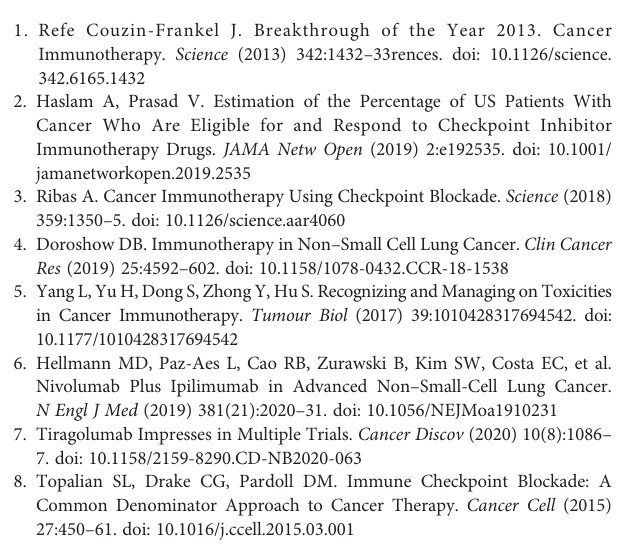
codon. The sequences of the primers used for ARMS-QPCR are indicated in bold font, and the sequence of the probe is shaded. Supplementary Figure 2 | Percentage of CD137+CD4+ T cells in the blood. (A) Gated CD3+, (B) CD4+, and (C) CD137+CD4+ T cells. (D) The percentage of CD137+CD4+ T cells in healthy controls and lung cancer patients. The error bars represent the SEMs. Supplementary Figure 3 | Correlation of Treg+ cell density in the tumor microenvironment with OS. Foxp3+ cells in the tumor microenvironment in TMAs from 82 lung cancer patients were detected by multiplexed QIF. (A) , Impact of Foxp3+ cell density on patient OS. Dichotomization was based on the median: red line, patients in the low-density group; blue line, patients in the high-density group. Log-rank P values are shown for each graph. (B) , Correlation of Foxp3+ cell density with OS in patients with a high number of in fi ltrating CD137+CD8+ cells in the tumor microenvironment. CD137+CD8+ cell dichotomization was based on the median. Supplementary Figure 4 | Structure and speci fi city of the therapeutic antibodies. (A) , Structural diagram of the therapeutic antibodies used in this study. A wild-type CD137 mAb (Wt-mAb, mIgG2a) and mutant CD137 mAb (Mut-mAb, mIgG2a) with D265A, N297A, L234A, L235A and P329A mutations in Fc g R were created via gene synthesis and expressed using a eukaryotic expression system. (B) , Binding of therapeutic antibodies to mouse CD137-His. The error bars represent the SEMs. Supplementary Figure 5 | Association of mCD137 protein expression with sCD137 protein expression. (A) , mCD137 expression and sCD137 levels in cell- free culture supernatant from non-Tregs and Tregs cultured under the indicated cell culture conditions for 3 days. (B) , mCD137 expression on CD4+ T subsets grown under the indicated culture conditions and sCD137 levels in the corresponding cell-free culture supernatant. (C) , mCD137 expression on CD8+ T subsets grown under the indicated culture conditions and sCD137 levels in the corresponding cell-free culture supernatant. Unstimulated, complete medium only; IL-2, complete medium + IL-2 (100 U/ml); CD28 mAb, complete medium + anti-human CD28 mAb (1 m g/ml); CD3 mAb, complete medium + anti-human CD3 mAb (OKT3, 1 m g/ml); IL-2+CD28+CD3, complete medium + IL-2 + anti- CD28 + anti-CD3; Treg, Treg + complete medium + IL-2 + anti-CD28 + anti-CD3. One representative assay of three experiments is